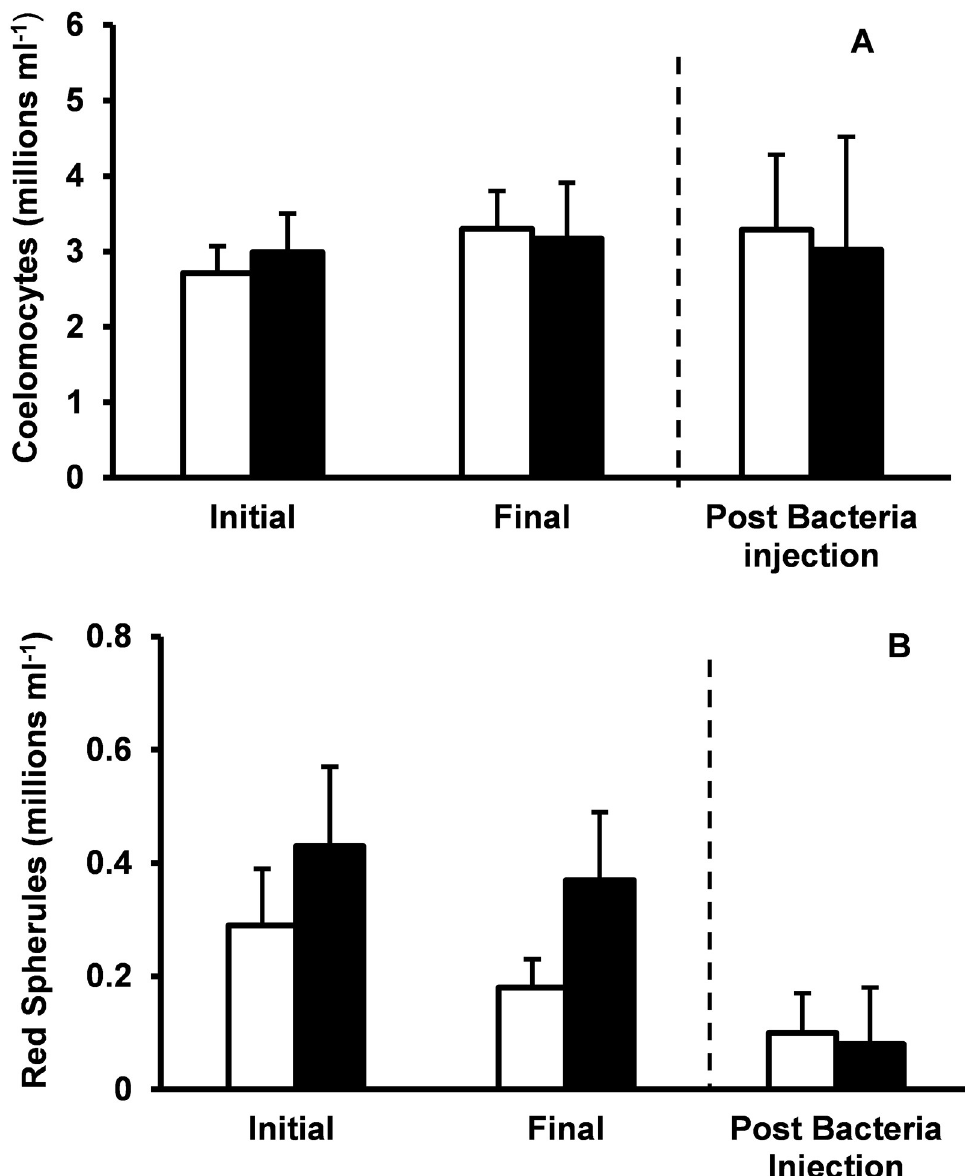
Fig 3. Change in coelomocytes. Total number of coelomocytes (A) and red spherules (B) per milliliter of urchin coelomic fluid in fed (white bars) and fasted (black bars) urchins. Cells were counted initially and 21 days after spine amputation. Following fasting, urchins were injected with Vibrio and coelomic cells counted 2 hours post injection. Mean values ± standard error are shown (n = 9 for each treatment group). Fasting had no significant impact on coelomocyte number compared to animals that were fed ( P > 0.05, RMANOVA). Decreases in coelomic cell numbers following injection of bacteria did not differ between fed and fasted urchins ( P > 0.05, unpaired